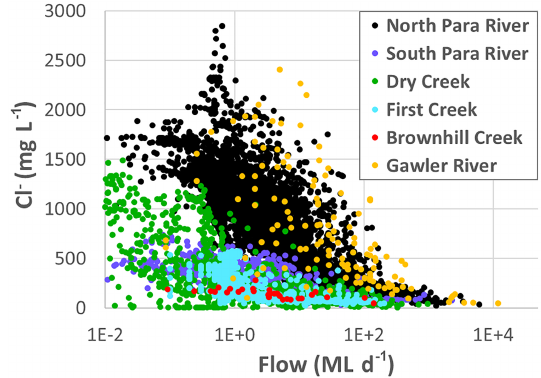
Figure 12. Scatter plot of chloride concentration versus streamflow rate for six streams running down from the Mount Lofty Ranges into the AP